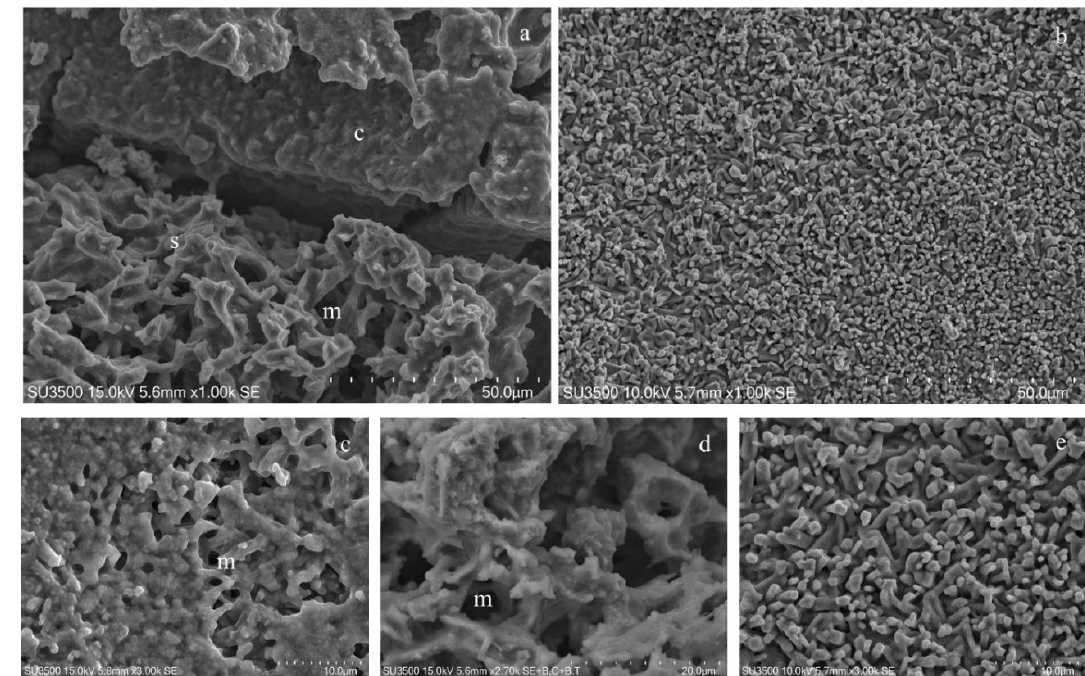
Figure 4. Characterization of S. wiggsiae ’s biofilm ultrastructural morphology. ( a ) At a low magnification, 1000×, biofilm shows a compact aspect on the top of the picture, c, spongy on the bottom, s, and a microcanalicular system is evident, m. ( b ) Biofilm surface shows a fine granular appearance, 1000×. ( c ) At higher magnifications, a more detailed architecture was distinguishable, compact areas were punctuated with holes, the openings of the microcanalicular system, m. 3000×. ( d ) Spongy areas reveal a trabecular architecture in whose spaces are a canalicular system, m, and unfold, 2700×. ( e ) The granular areas were uneven surfaces due to the presence of digitiform extroversions of the biofilm matrix, 3000×.